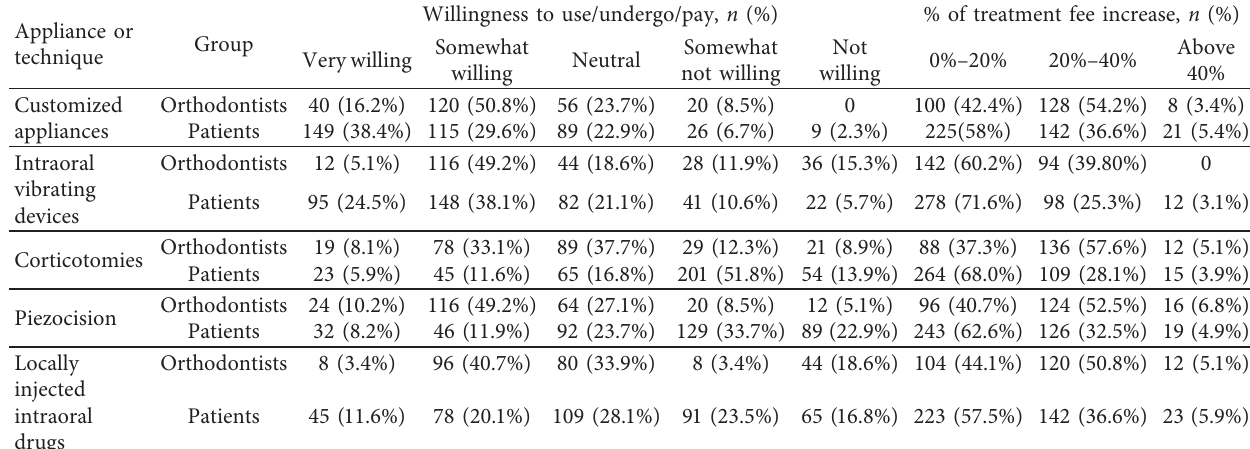
Table 3: Willingness to use or undergo and pay for different